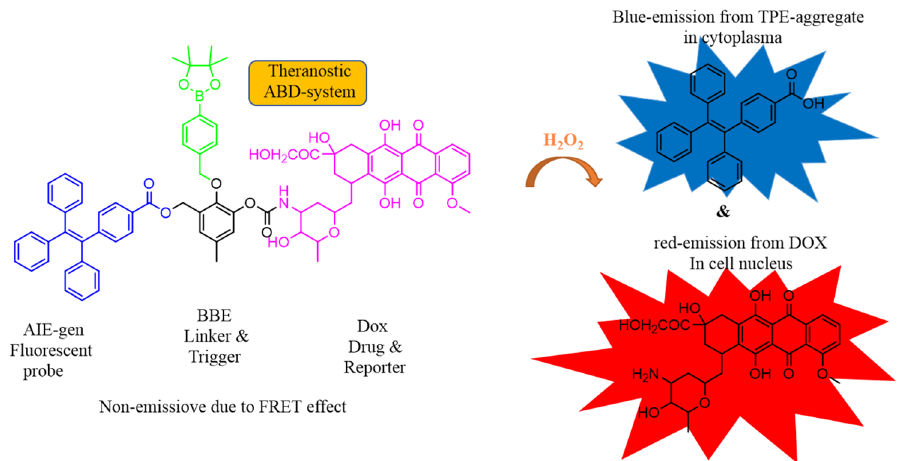
Figure 27. Representative chemical structures of the DDSs system along with working mechanism towards the response to H 2 O 2 . Reprinted from [143] with the permission of The Royal Society of Chemistry. Molecules 2022 , 27 , x FOR PEER REVIEW